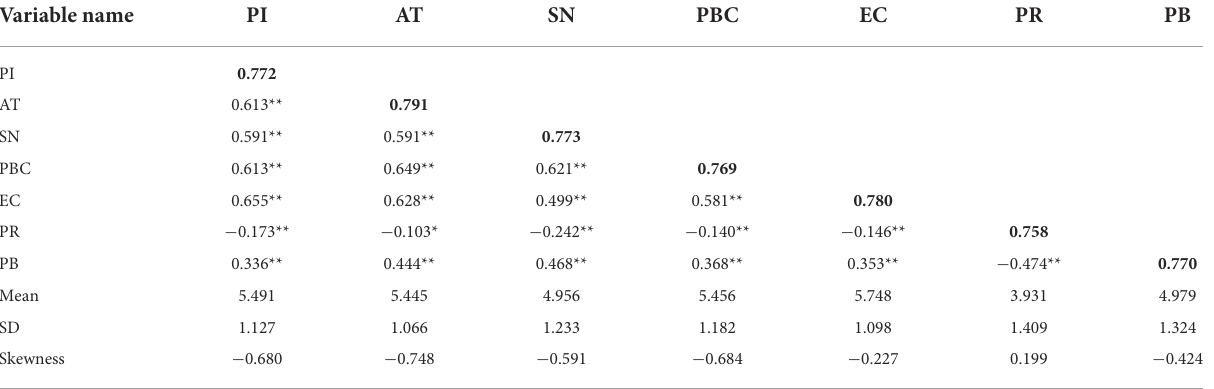
TABLE 3 Correlations, divergent validity, and descriptive